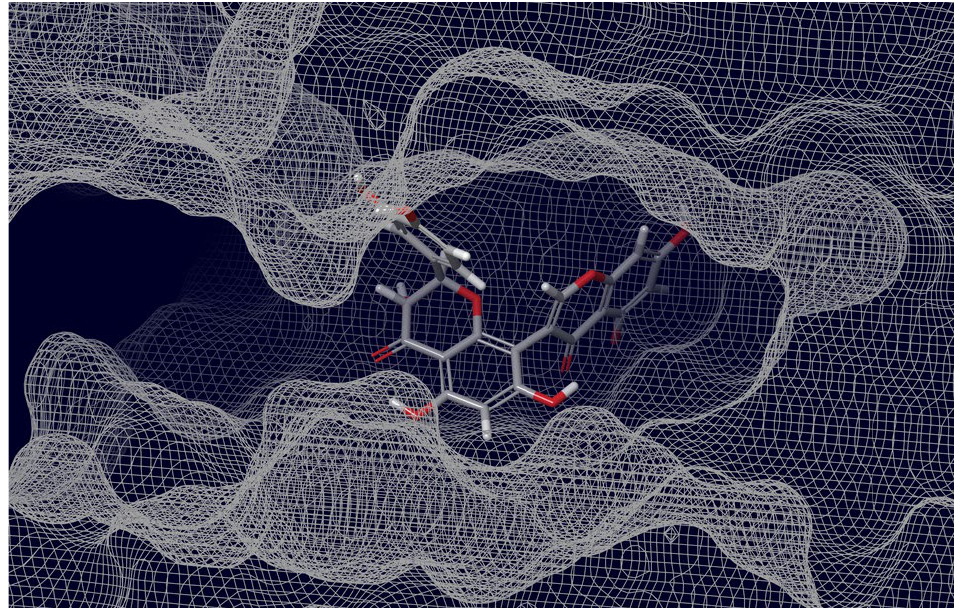
Figure 10. Interaction of ACE2 with Preussianone, the latter aligned with the c active site environment of the receptor complex (PDB ID: 7T9L).